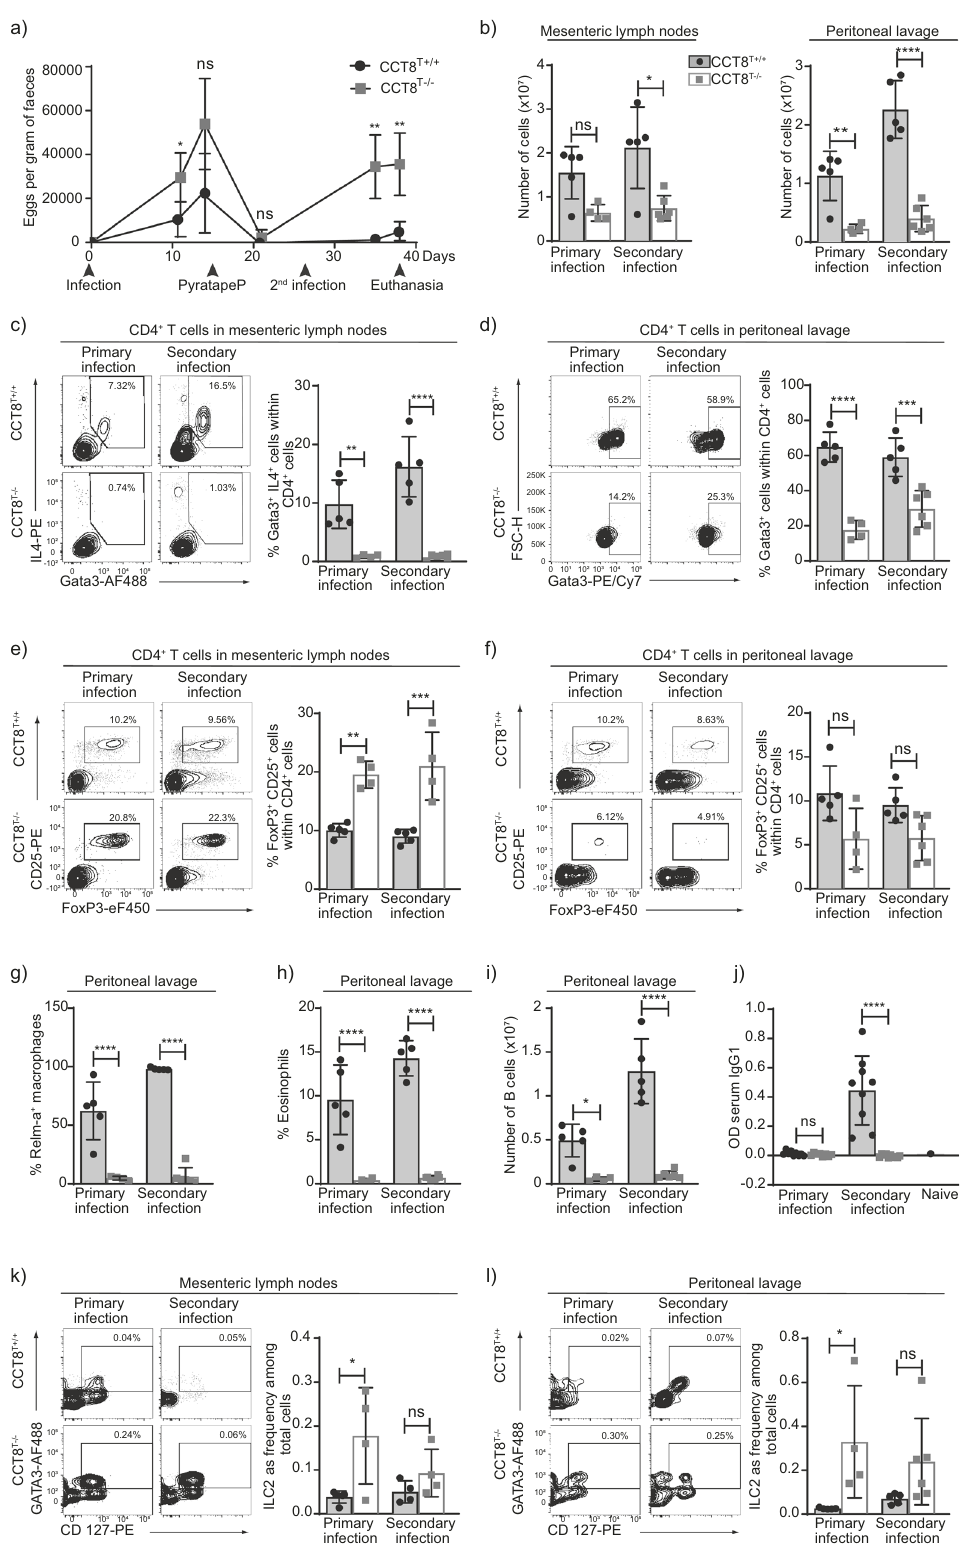
Fig. 5 The response to primary and secondary H. polygyrus infection. a Eggs per gram of faeces at indicated timepoints. Comparison of CCT8 T + / + (black circles) and CCT8 T − / − mice (grey squares). b Cellularity in mesenteric lymph nodes, and peritoneal lavage. c Th2 cell frequency in mesenteric lymph nodes, and d peritoneal lavage. e Treg frequencies in mesenteric lymph nodes, and f peritoneal lavage. Frequencies of ( g ) alternatively activated macrophage and ( h ) eosinophils in peritoneal lavage. i B cells in peritoneal lavage, and j H. polygyrus -speci fi c serum IgG1. ILC2 frequency in mesenteric lymph nodes ( k ) and peritoneal lavage ( l ). c – f and k , l Display of contour plots with gating. * p < 0.05, ** p < 0.01, *** p < 0.001, **** p < 0.0001. Data were compared by Student ’ s t -test adjusted for multiple comparison (Holm-Sidak method). Bar graphs show mean ± SD and are representative of one of the two independent experiments with at least 4 samples per